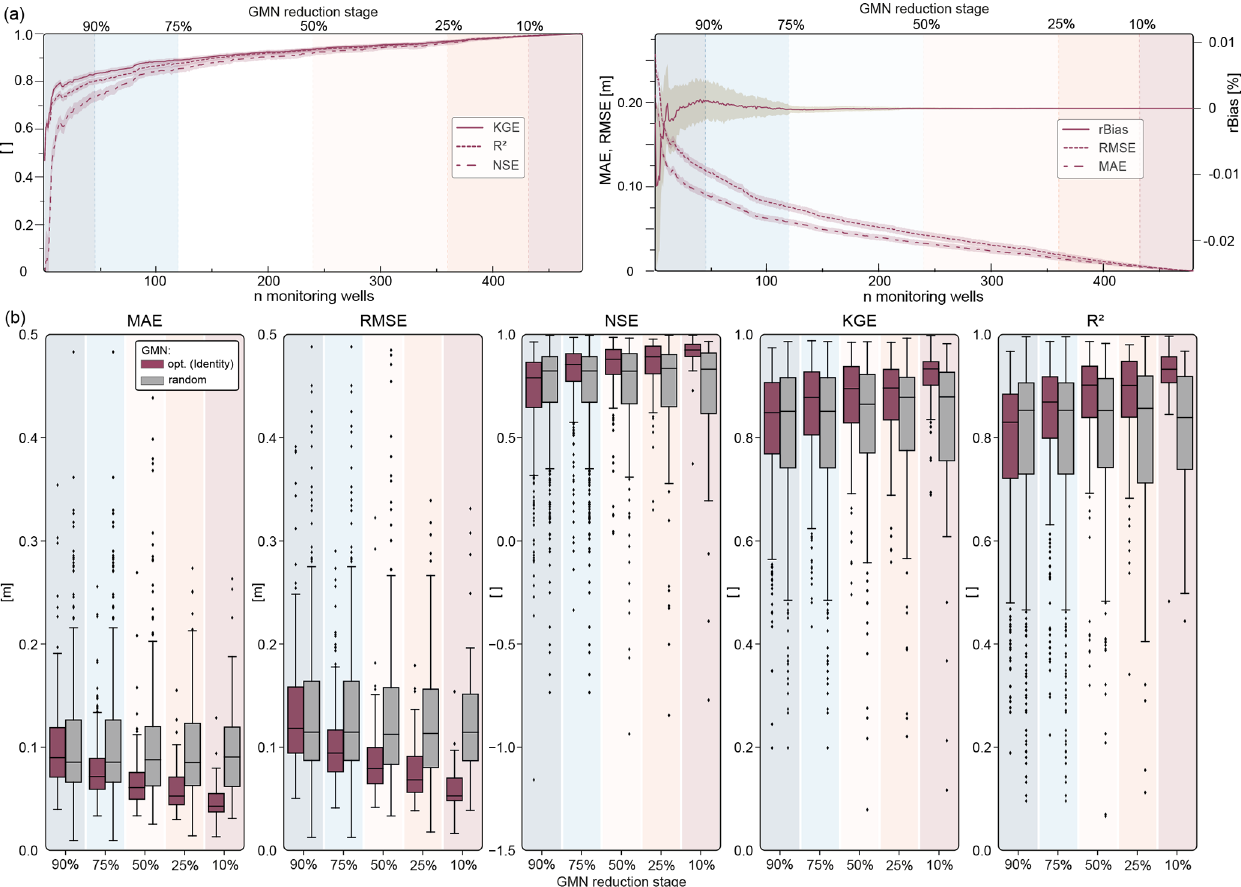
Figure 5. (a) Reconstruction error metrics (KGE, R 2 , NSE, MAE, RMSE, and rBias) as a function of the number of QR-ranked remaining monitoring wells for the identity basis and 1043 basis modes (lines are mean values, and shading represents the total range of reconstruction errors over all removed wells). (b) Same reconstruction error metrics with a GMN reduction of 10%, 25%, 50%, 75%, and 90%, as boxplots, compared to the same number of randomly removed wells